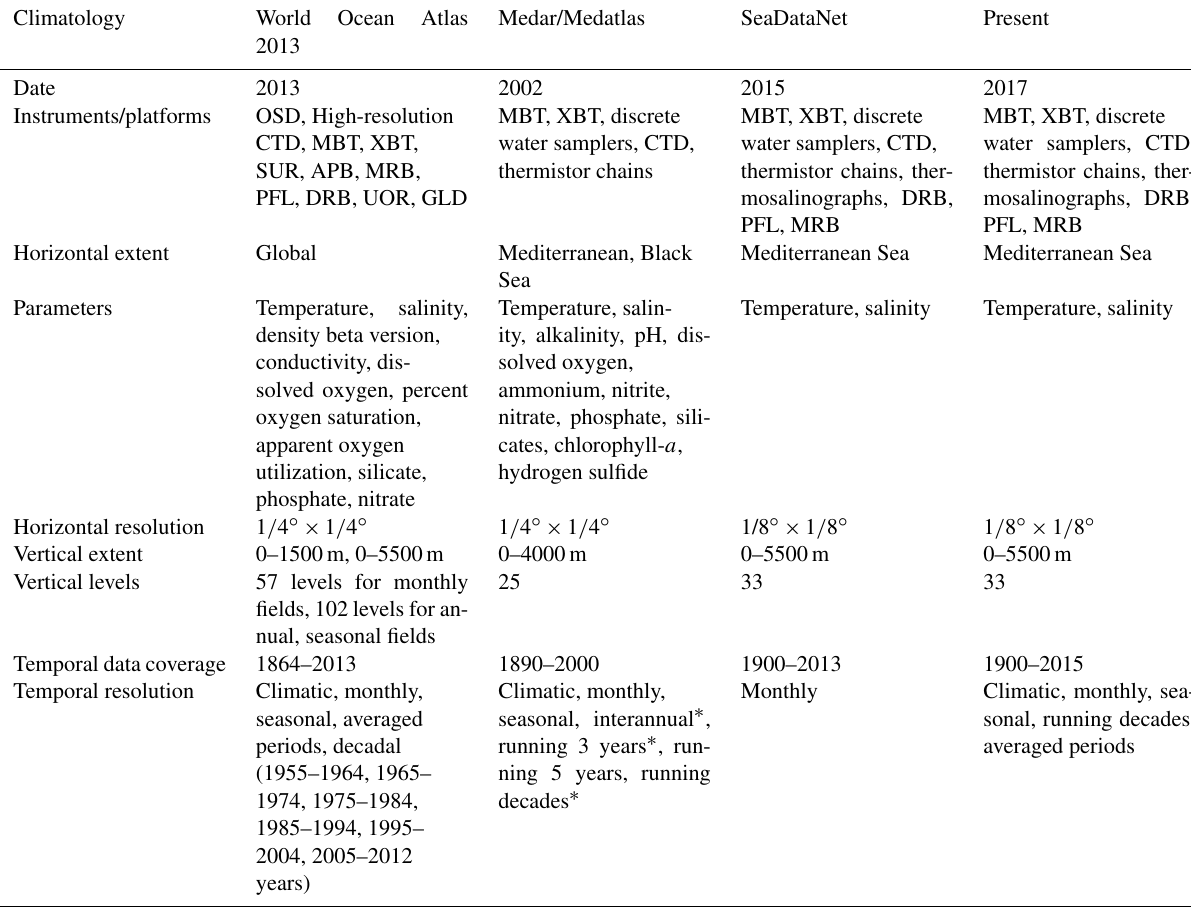
Table 1. Overview of characteristics of existing T/S climatologies in Mediterranean Sea. OSD = Ocean Station Data, CTD = conductivity–temperature–depth, MBT = mechanical–digital–micro bathythermograph, XBT = expendable bathythermograph, SUR = surface, APB = autonomous pinniped bathythermograph, MRB = moored buoy data, PFL = profiling float data, DRB = drifting buoy, UOR = undulating oceanographic recorder, GLD = glider.